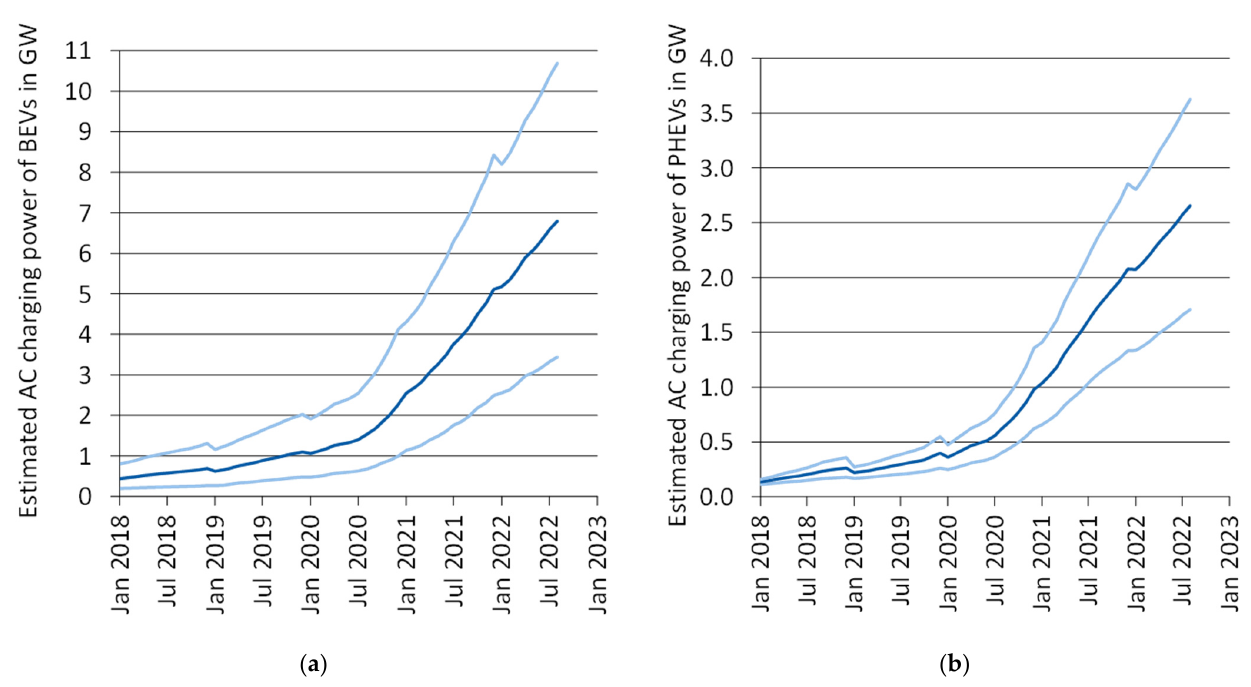
Figure 3. Estimated AC charging powers of ( a ) BEV fleet and ( b ) PHEV fleet. The surrounding light- blue lines are the error corridor that results from the fact that the national car registry’s identification system does not differentiate between the charging powers of different car-model versions. It has to be noted here that the charging powers shown are the rated power values of the vehicles. Because not all vehicles charge simultaneously, the grid will only be loaded by a fraction of the shown values. The same holds true for the DC values shown in Figure 4.